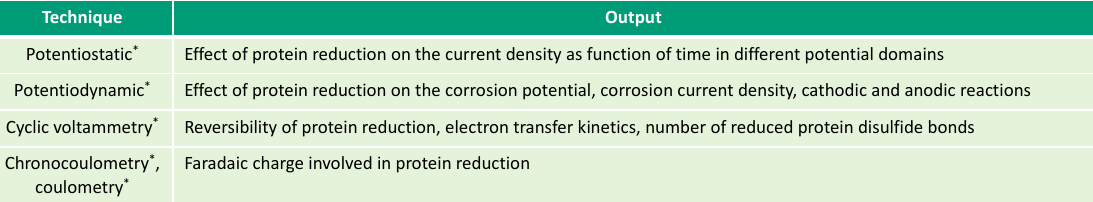
Figure 4. Spectroscopic techniques used for investigation of albumin-metal binding (* in-situ techniques). Figure 5. Techniques (in green—electrochemical, in-red—microscopic and spectroscopic) used for investigation of albumin precipitation (* in-situ techniques). Electrochemical techniques are the experimental techniques used to study in-situ the interaction of proteins with biomedical alloys [58]. Particularly, potentiostatic and potentiodynamic tests are extensively used and useful for understanding and quantifying protein adsorption, precipitation, and reduction [24,29–31,34,39,55,56] as these phenomena are influenced by the prevailing potential at the interface. During a potentiostatic test, a target potential is applied to the metal samples by means of a three-electrode set-up connected to a potentiostat which measures the current at the constant potential as a function of the time allowed following the electrochemical kinetics of the involved reactions. It allows us to quantify the amount of dissolved metal (faradaic reactions) but, also, to impose different surface conditions (i.e., formation of a certain oxide film by imposing an appropriate potential within the passive domain of a CoCrMo alloy or stainless steel). Chronocoulometry and coulometry are electrochemical techniques used for the determination of the faradaic charge for BSA reduction [49] and can be considered a specific use of the potentiostatic technique. More specifically, potentiostatic coulometry is an electrochemical technique in which the constant potential is applied to the working electrode while the current that flows through the circuit is measured. Applying a constant potential for a sufficient amount of time allows it to fully oxidize or reduce all of the electroactive species in the solution (i.e., BSA). As the electroactive molecules are consumed, the current also decreases and approaches zero when the conversion is complete. During the chronocoulometric technique, the entire charge that passes under the application of a step potential is recorded as a function of time. Integration of the current through the applied potential allows us to calculate the charge [59].